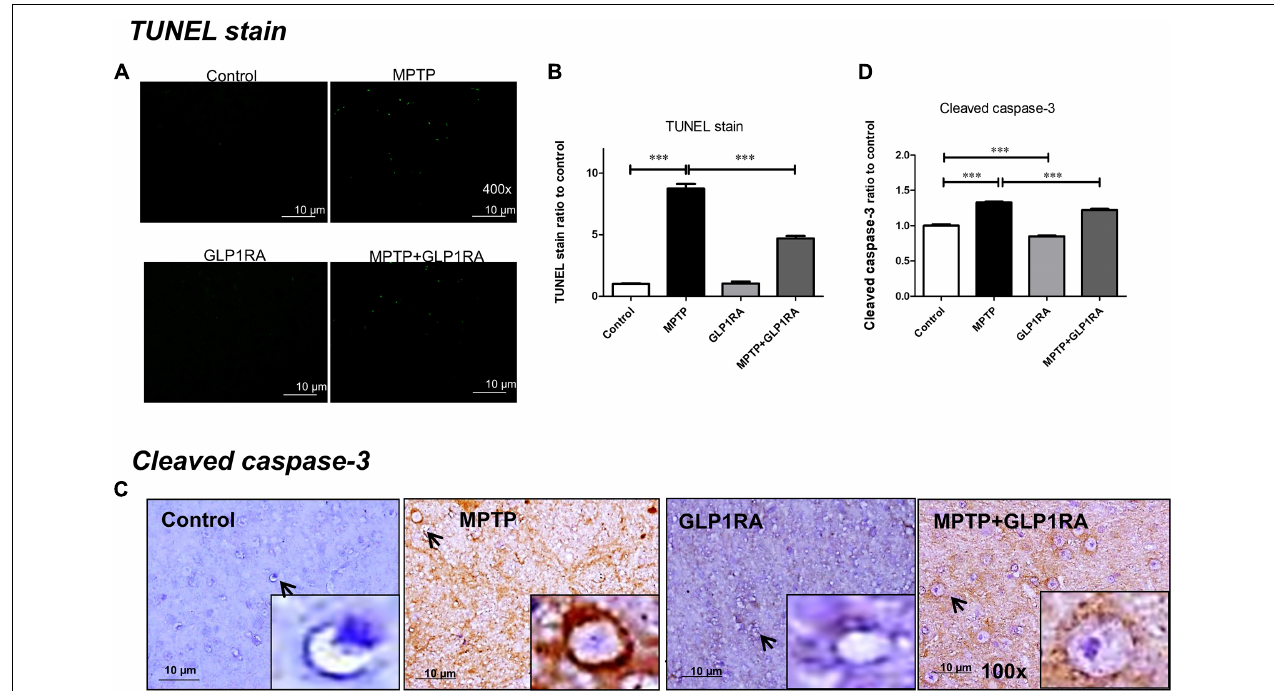
FIGURE 4 | The GLP-1RA (liraglutide) attenuated MPTP-induced apoptosis in the substantia nigra. Mice were treated according to the four groups: control/MPTP/GLP-1RA/MPTP + GLP-1RA. (A,B) Terminal deoxynucleotidyl transferase-mediated dUTP-biotin nick end labeling (TUNEL) staining: TUNEL positive apoptotic cells of substantia nigra tissues were visualized under a fluorescent microscope 400x (green) and quantified via staining intensity to percentage of the control using ImageJ software. Scale bar = 10 µ m. n = 3 per group. (C,D) Cleaved caspase-3 staining: IHC-staining of substantia nigra tissues were visualized under a light microscope 400x. Note that representative cells are denoted by arrows and caspase-3-positive neurons are identified by brown staining while the counterstain hematoxylin is shown in blue. Quantification through staining intensity was done using ImageJ software. Scale bar = 10 µ m. n = 3 per group. The values represent mean ± SD (one-way ANOVA, * P < 0.05, ** p < 0.01, *** P < 0.001). GLP-1RA, glucagon-like peptide-1 receptor